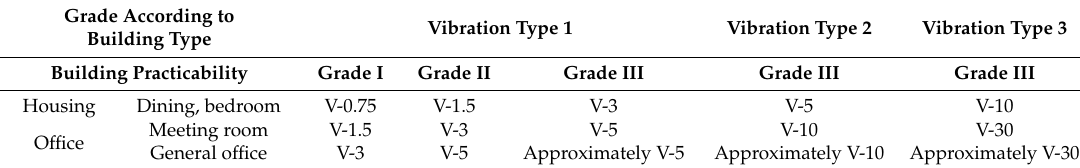
Table 11. Natural frequency and maximum acceleration [11].